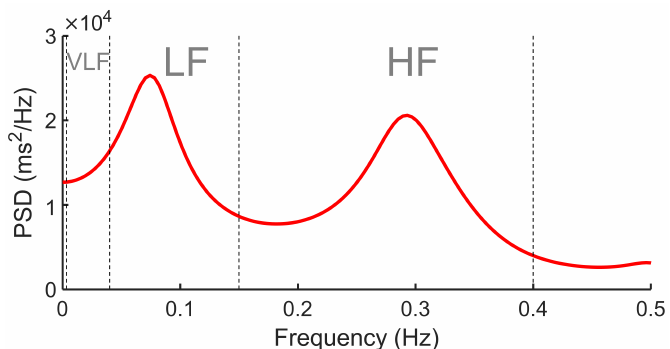
Figure 4. Spectrum of a HRV